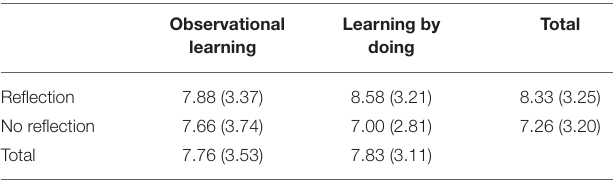
TABLE 4 | Mean Scores (SD) on Initial Writing Performance (min. score 0, max. score 12).